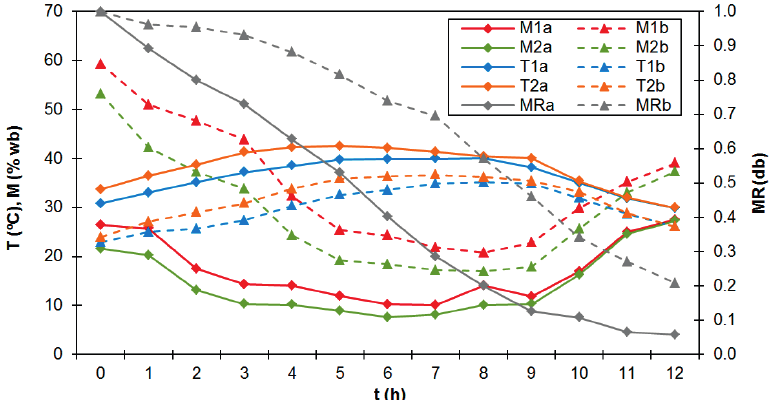
Figure 15. T , M and MR variation of OMW for two situations.